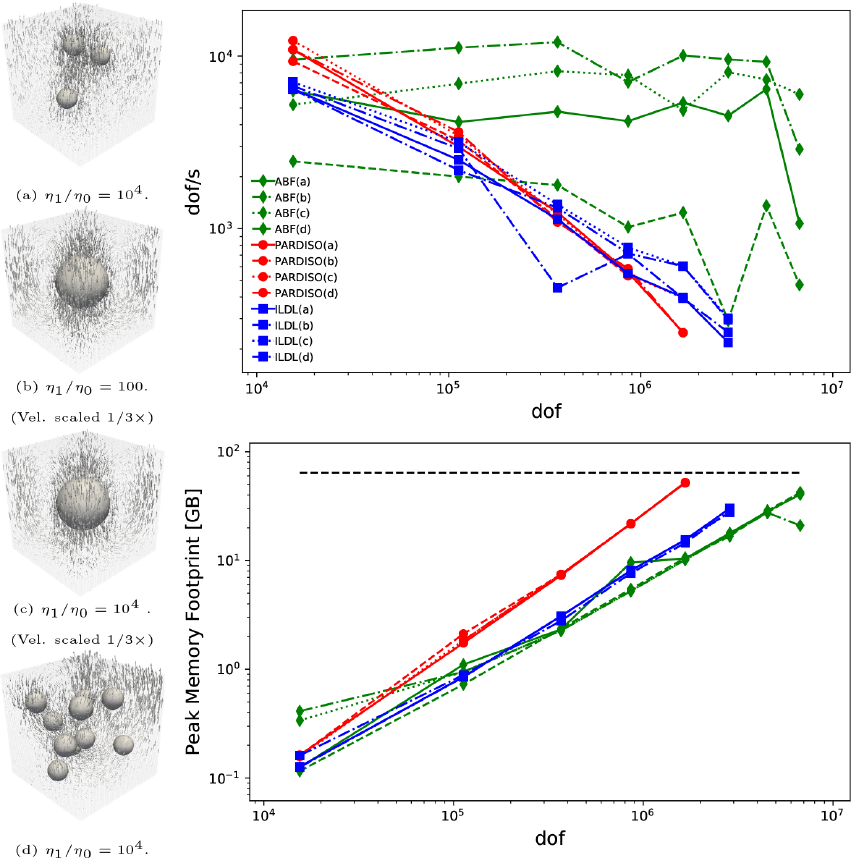
Figure 1. Additional experiments, corresponding to the coefficient structures labeled (a) – (d) , analogous to those in Table 1. Inclusion radii are 0 . 25 for single inclusions and 0 . 1 otherwise, in the unit cube. Solver performance is assessed in terms of degrees of freedom solved to the prescribed tolerance (10 − 6 relative error in the true residual norm) over the solution time, and by peak memory